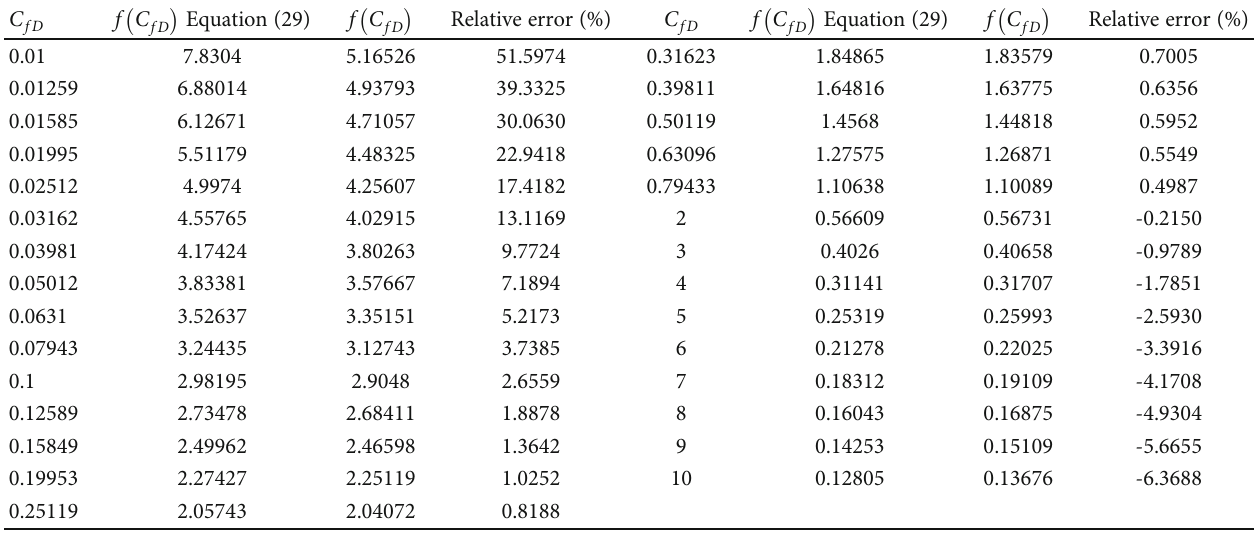
Table 1: Fracture conductivity in fl uence function.